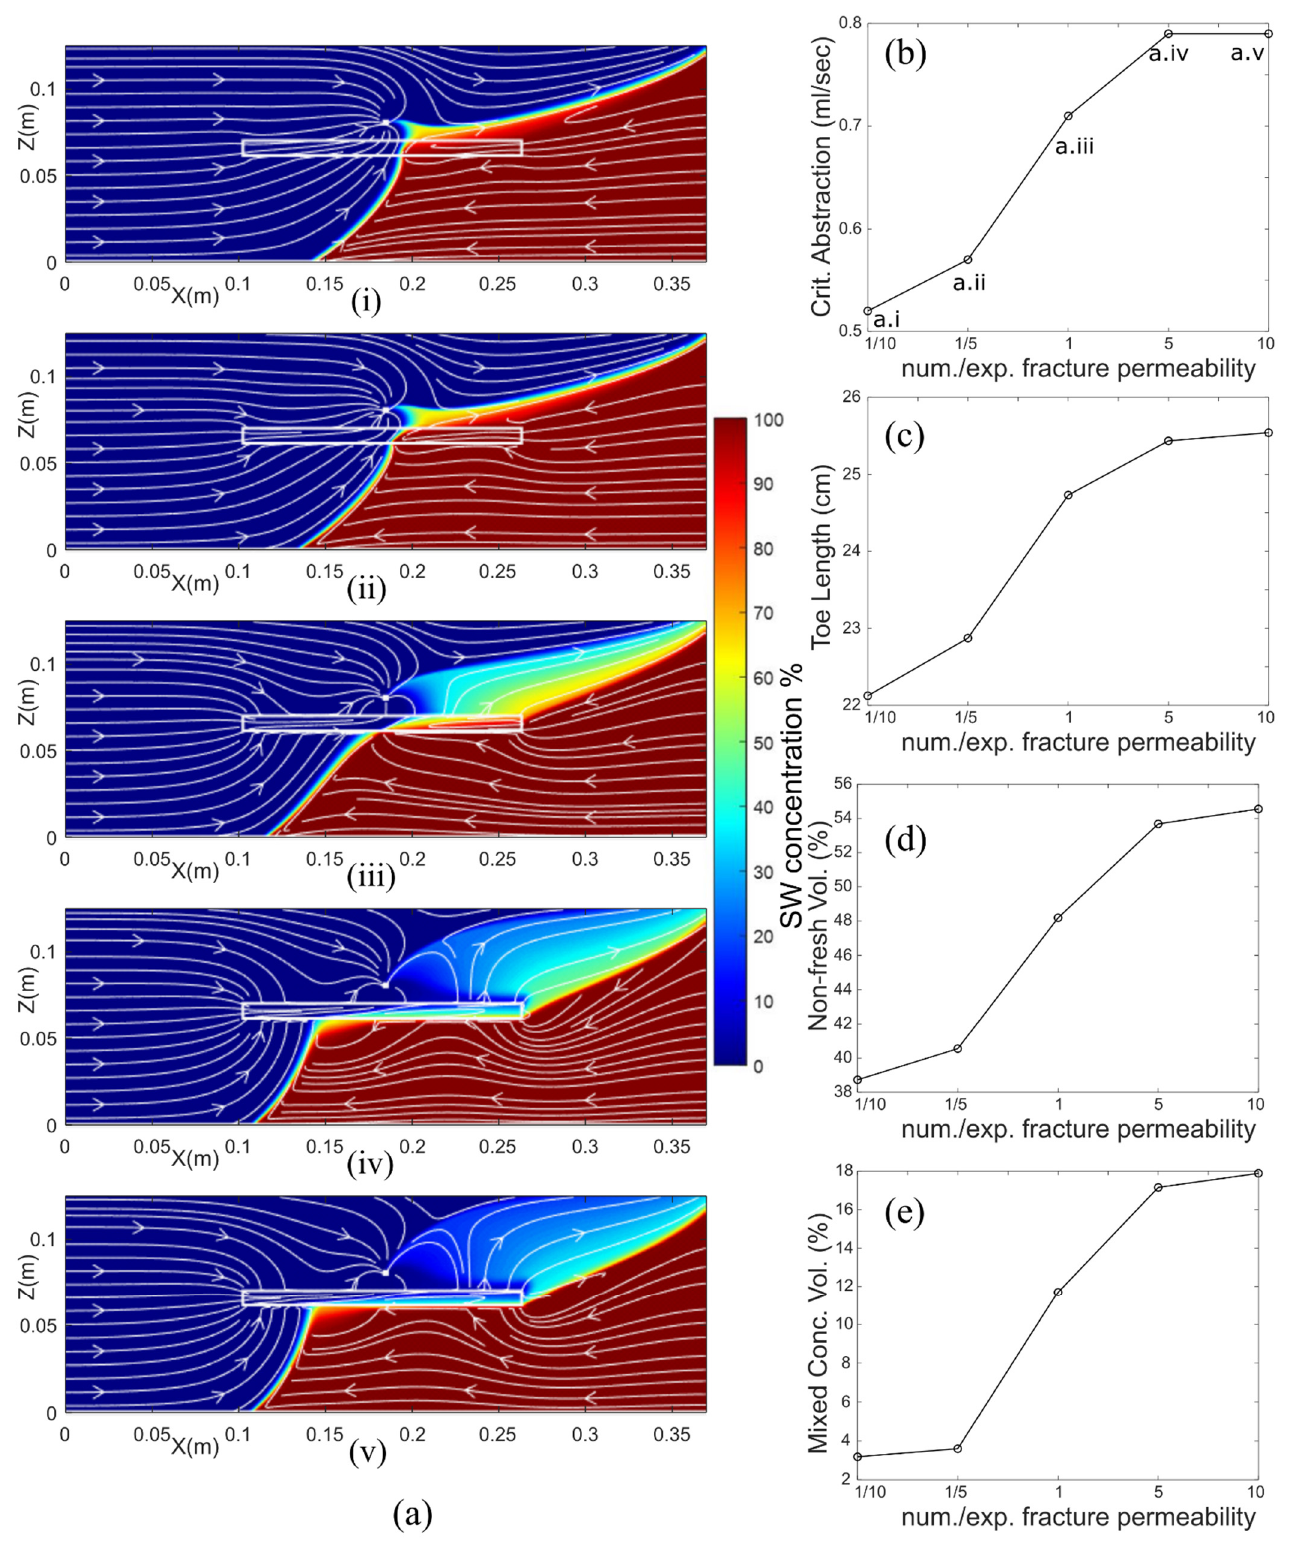
Figure 12. Simulated ( a ) critical SW concentration fields alongside their corresponding values of ( b ) critical abstraction rates, ( c ) toe length, ( d ) non-fresh and ( e ) mixed-concentration volume fractions, demonstrating the impact of the fracture permeability on the saltwater upconing mechanism.